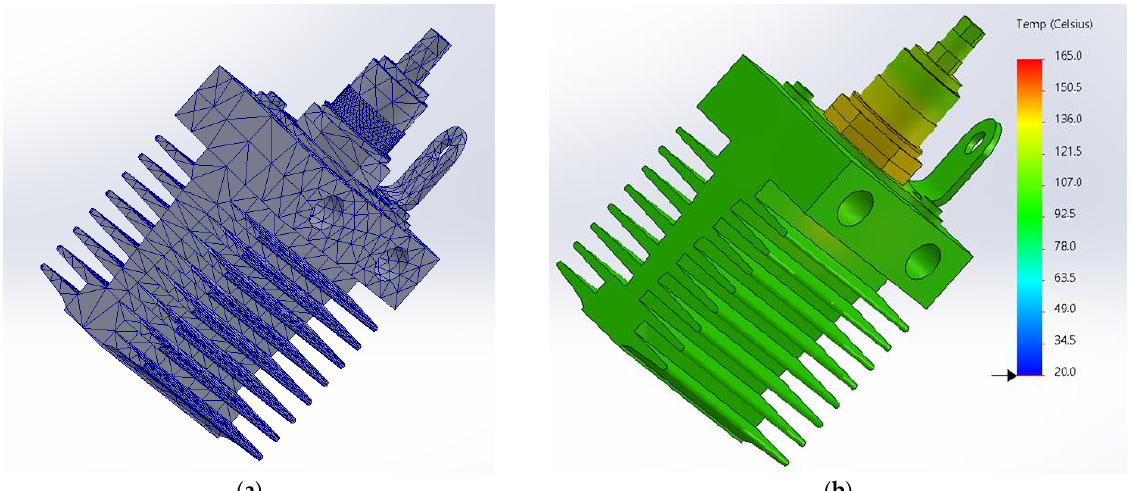
Figure 11. ( a ) The view of the diode model for the smallest mesh element value of 5.5 mm. ( b ) The simulation result for the smallest mesh element value of 5.5 mm ( t s = 12 s; T j = 150.5 °C; P j = 117.99 W; the temperature ranges from 20 °C to 165 °C).